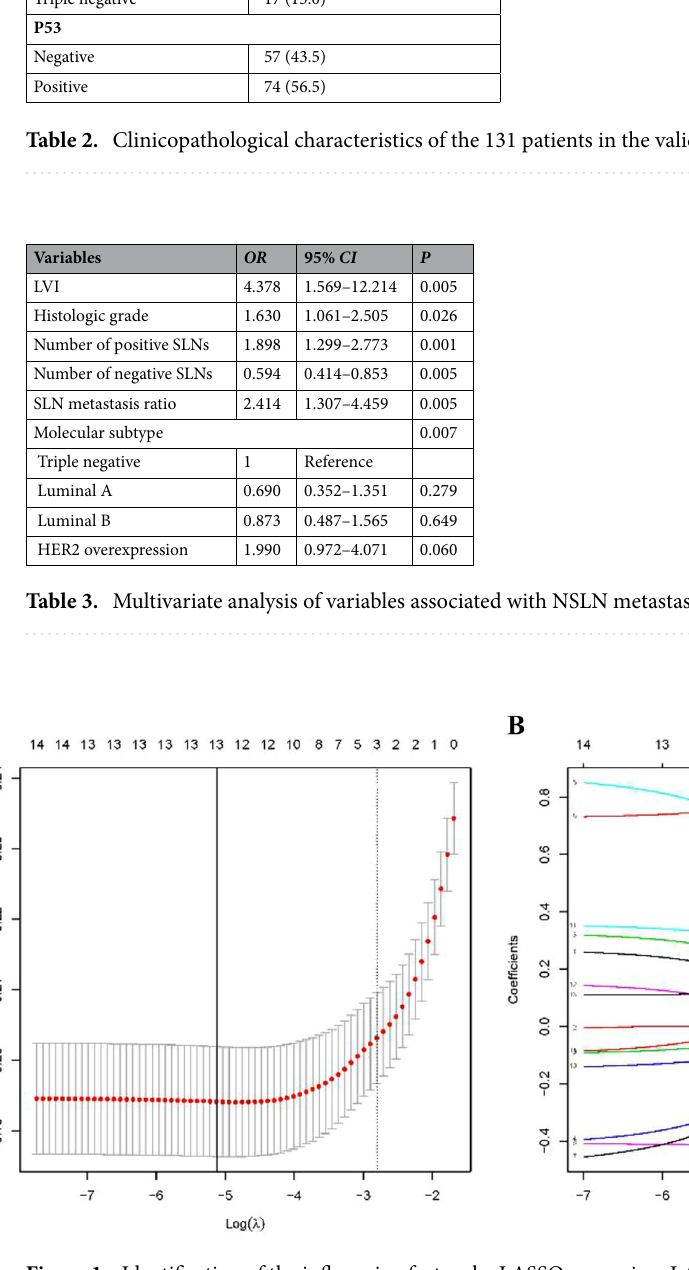
Figure 1. Identification of the influencing factors by LASSO regression. LASSO regression identified the following 13 most powerful predictors: ( A ) age group, clinical tumour stage, histologic type, number of positive SLNs, number of negative SLNs, number of SLNs dissected, SLN metastasis ratio, ER status, PR status, HER2 status, Ki67 staining percentage, molecular subtype and P53 status. Plot ( B ) shows the coefficients of each predictor when the 13 predictors were included in the LASSO regression